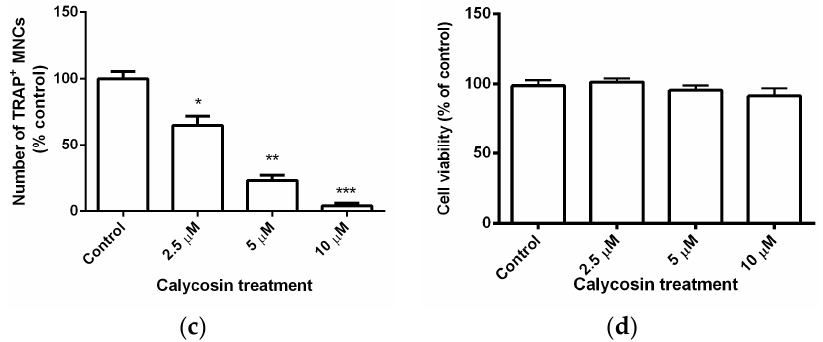
Figure 1. Effects of calycosin on osteoclast differentiation. ( a ) Chemical structure of calycosin; ( b ) BMMs were cultured with indicated dose of calycosin in the presence of M-CSF (20 ng/mL) and RANKL (20 ng/mL). After three days, cells were fixed and stained for TRAP staining assay; ( c ) TRAP-positiveMNCs containing three or more nuclei were counted as osteoclasts; and ( d ) cell viability was measured using MTT assay. The results were expressed as means ± SD from three independent experiments. Scale bar represents 50 μ M. * p < 0.05; ** p < 0.01; *** p < 0.001 vs. control.